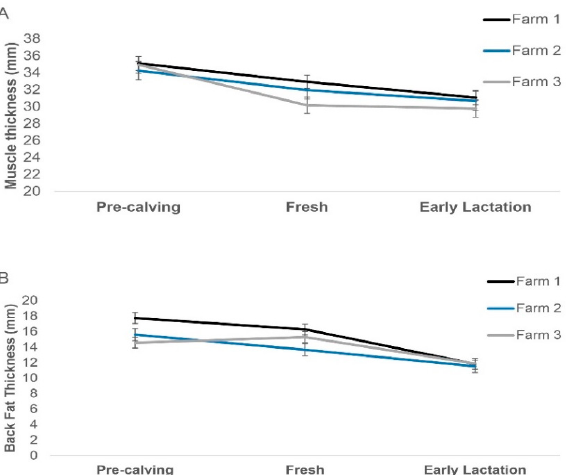
Figure 1. Adjusted means (±standard error) for muscle thickness ( A ) or back fat thickness ( B ) at different time-points and for the three different farms enrolled in this study.